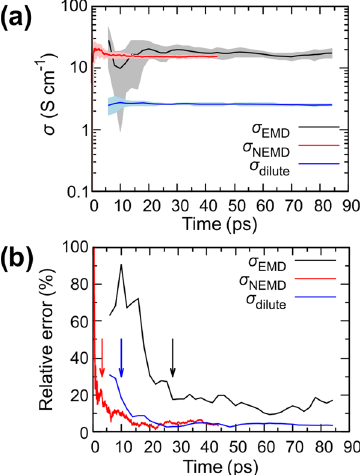
Fig. 3 Validation and ef fi ciency of CCD-NEMD. a Cumulative averaged conductivities ( σ dilute , σ EMD , and σ NEMD ) and b the relative errors along c -axis at 1200 K. Each colored arrow corresponds to a position with a relative error of 20%. The lines and error bars indicate the average and standard deviation of the fi ve independent samples with different initial velocities,